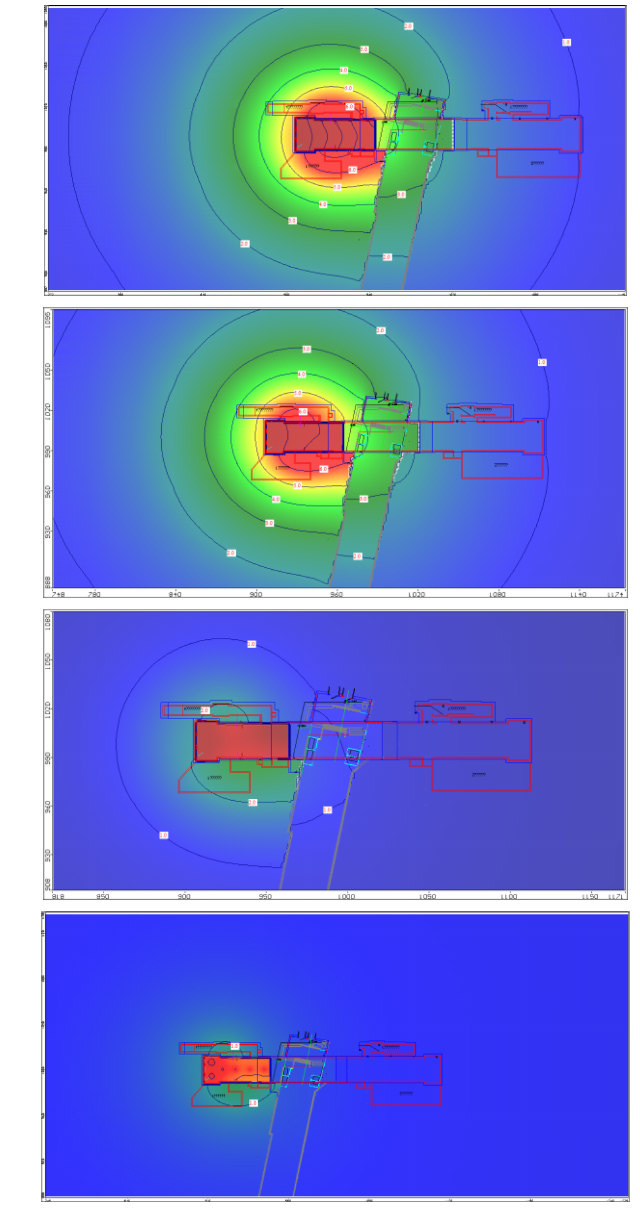
Figure 3. Contour map of groundwater level drawdown after foun- dation pit dewatering 90d later under different depths (34, 37, 43, 48m) of the waterproof curtain conditions (unit: m).